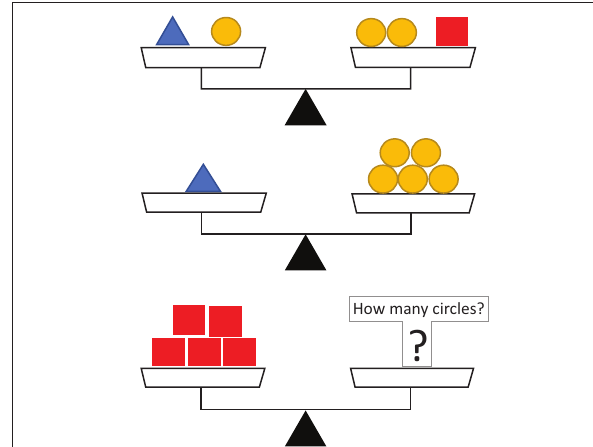
FIGURE 5: Task 6. Vignette: